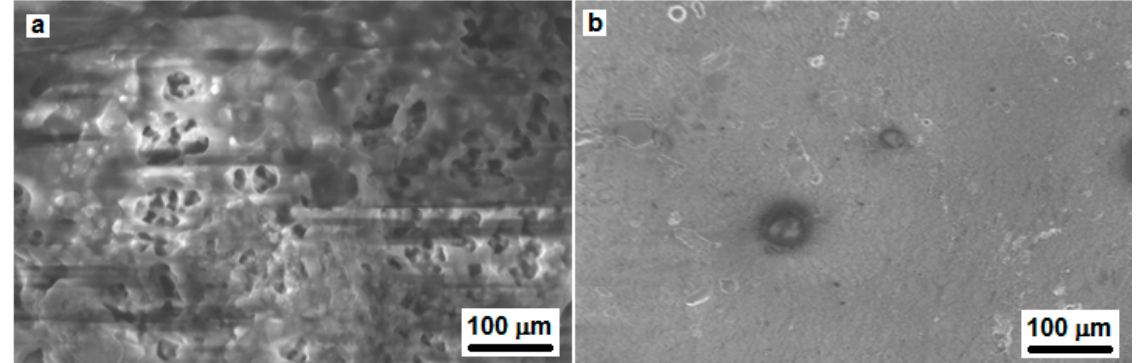
Figure 9. SEM images of MS: ( a ) absence of inhibitor and ( b ) presence of T. aralioides inhibitor extract. EDX was implemented to discover the elements in the MS coupons that were in contact with the aggressive solution (1M HCl) in the presence and absence of the inhibitor. Table 6 exemplifies the test results. Table 6. Elemental composition of the MS specimen in the absence and presence of inhibitor.